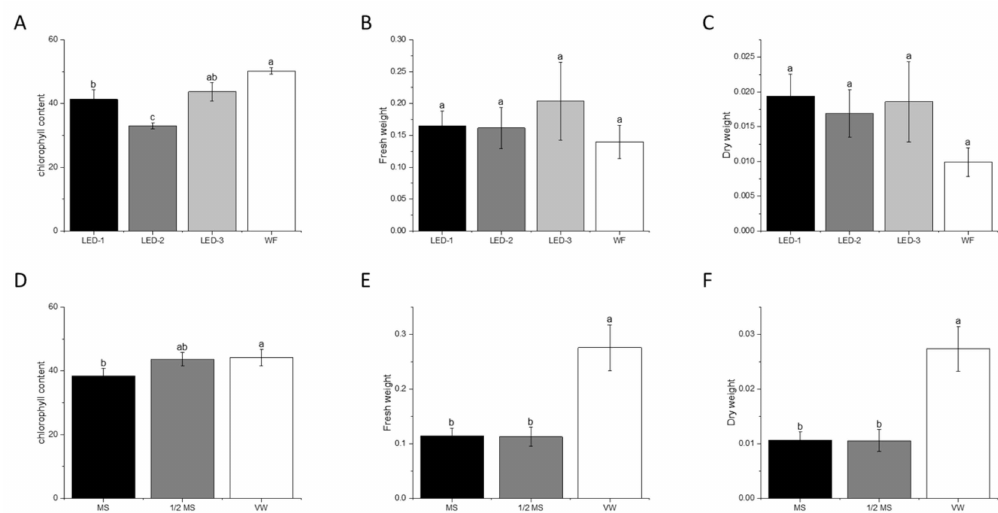
Figure 5. Effects of light sources and culture media on relative chlorophyll content ( A , D ), fresh weight (g) ( B , E ), and dry weight (g) ( C , F ) of Stage III B. nodosa in vitro plantlets after 60 days of culture establishment. LED-1: Light-emitting diode (LED) light with 1575 ± 50 µ mol m − 2 s − 1 Photosynthetic Photon Flux Density (PPFD); LED-2: LED light with 1015 ± 50 µ mol m − 2 s − 1 PPFD; LED-3: LED light with 80 ± 5 µ mol m − 2 s − 1 PPFD; and WF: white fluorescent light with 50 ± 5 µ mol m − 2 s − 1 PPFD. MS: MS basal medium supplemented with 30 g L − 1 sucrose and 7 g L − 1 agar; 1 / 2 MS: half-strength MS basal medium supplemented with 15 g L − 1 sucrose and 7 g L − 1 ; VW: VW basal medium supplemented with 10% coconut water, 20 g L − 1 sucrose and 7 g L − 1 . Bars indicate mean ± SE. Different letters indicate significant differences by Tukey’s test at p ≤ 0.05.